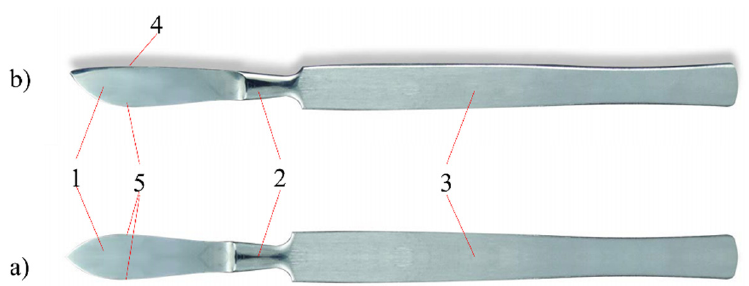
Figure 1. Construction of a scalpel: 1—working part; 2—neck; 3—grip part; 4—back end; 5—cutting edge. ( a ) sharp-tipped; ( b ) ventral.